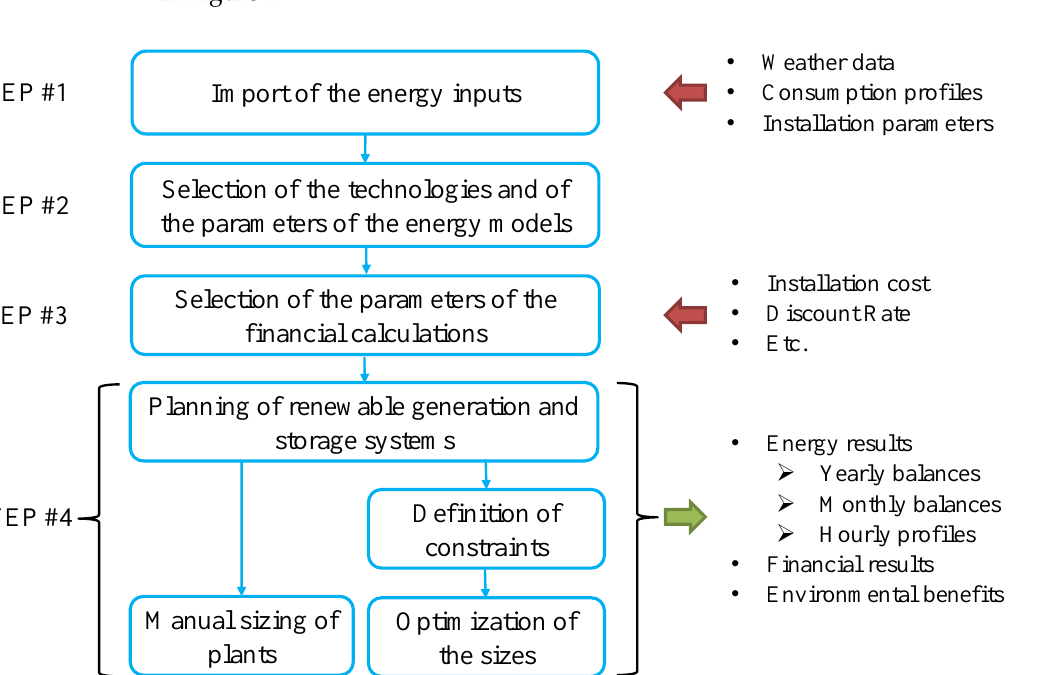
Figure 2. Scheme of the procedure used in the tool with indication of the inputs/outputs.